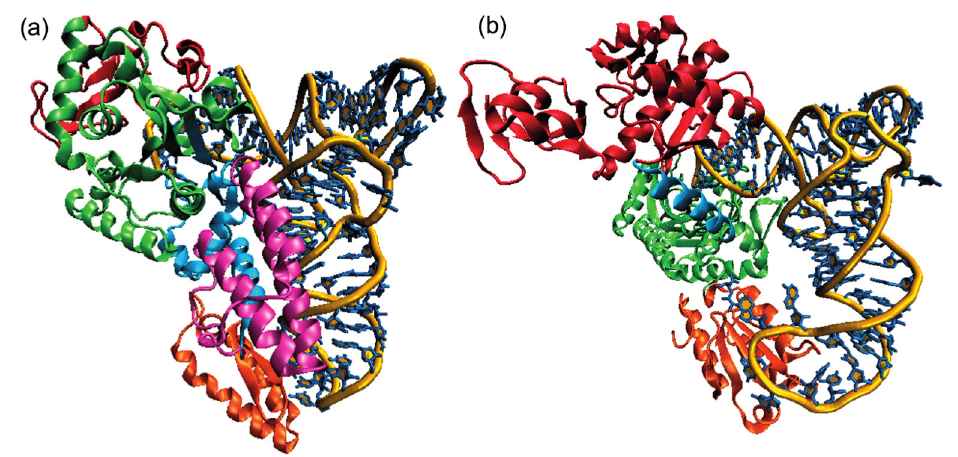
Figure 3. Structures of Class I and Class II AARSs ( a ) E. coli CysRS:tRNA Cys complex. The CP domain (red) and Rossmann fold catalytic domain (green), stem contact fold (cyan), helical bundle domain (magenta), and anticodon binding domain (orange) of CysRS are shown in a ribbon diagram; ( b ) A single monomer of the homodimeric E. coli ThrRS:tRNA Thr complex. The two N-terminal domains (red), catalytic domain (green), linker (cyan), and anticodon binding domain (orange) of ThrRS are shown in a ribbon diagram. For both structures, the tRNAs are shown in a stick diagram (blue) with a trace of its backbone (yellow).